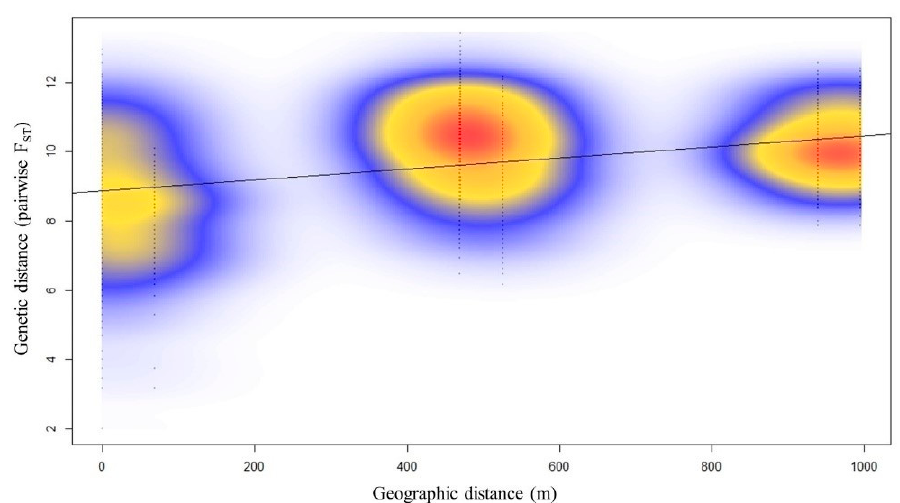
Figure 3. Isolation-by-distance scatterplot using kernel density estimate of N. shimadai between the matrix of genetic distance (pairwise F ST ) and geographic distance (meters) in northern Taiwan. The genetic distance and geographic distance show a significant positive correlation (r = 0.3715).